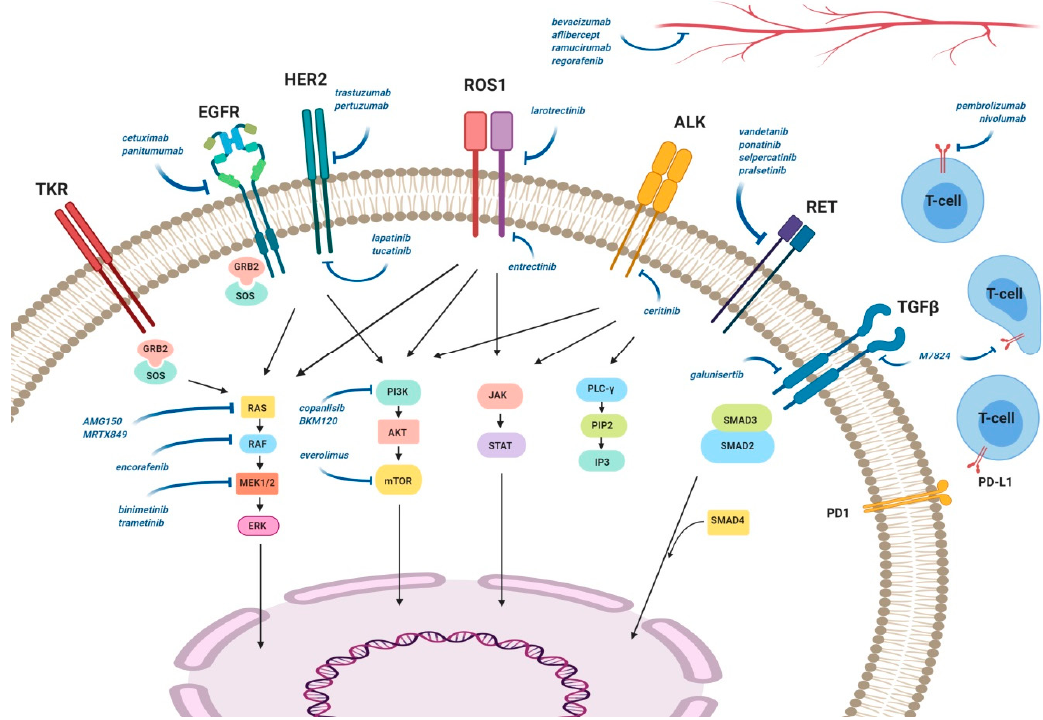
Figure 1. Potential targets and drugs for molecular-biology-driven treatment for metastatic colorectal cancer.